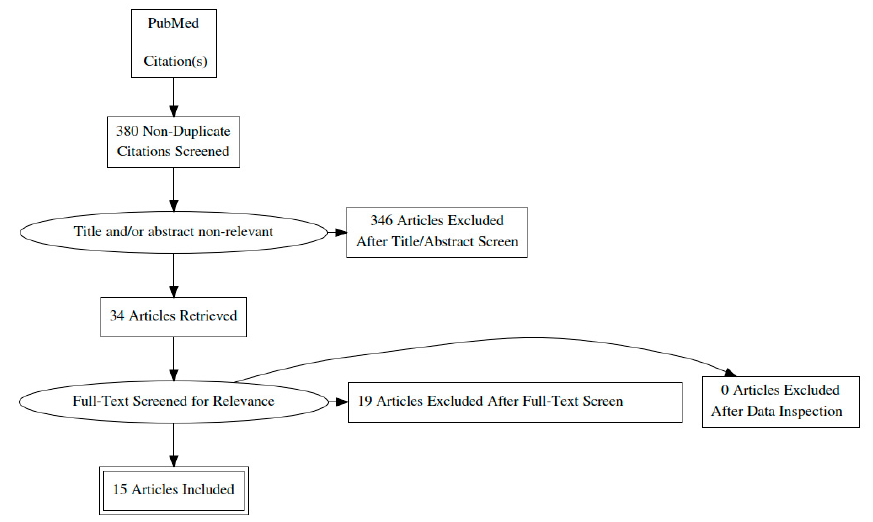
Figure 1. PRISMA diagram of the literature search process.